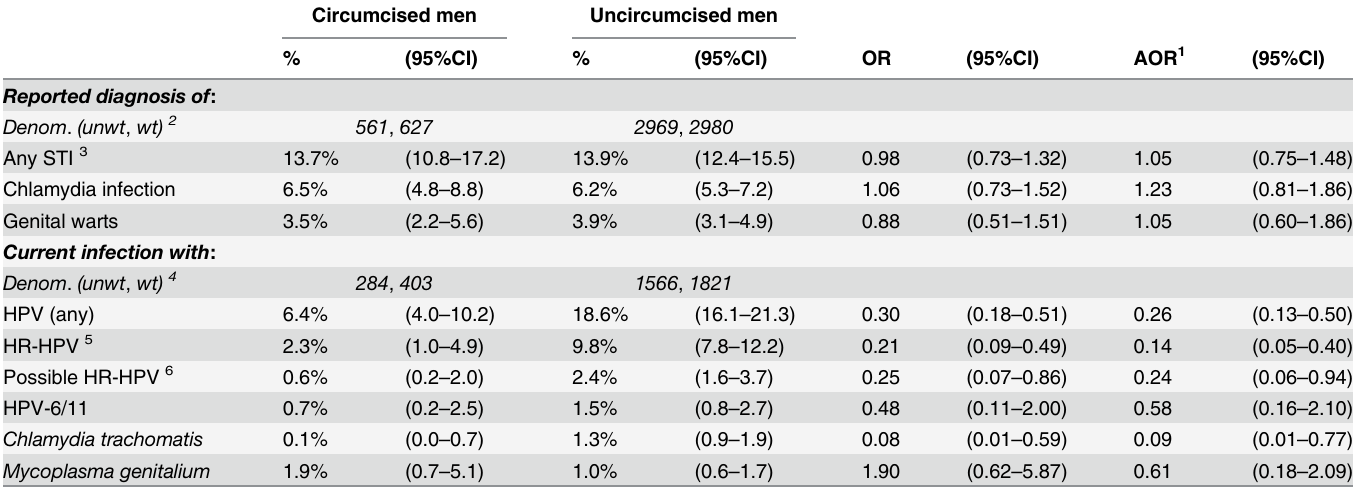
Table 2. Variations in the reported diagnosis of, and detection of, current infection, of key STIs among sexually-experienced men aged 16 – 44 years in Britain ’ s third National Survey of Sexual Attitudes and Lifestyles (Natsal-3). Circumcised